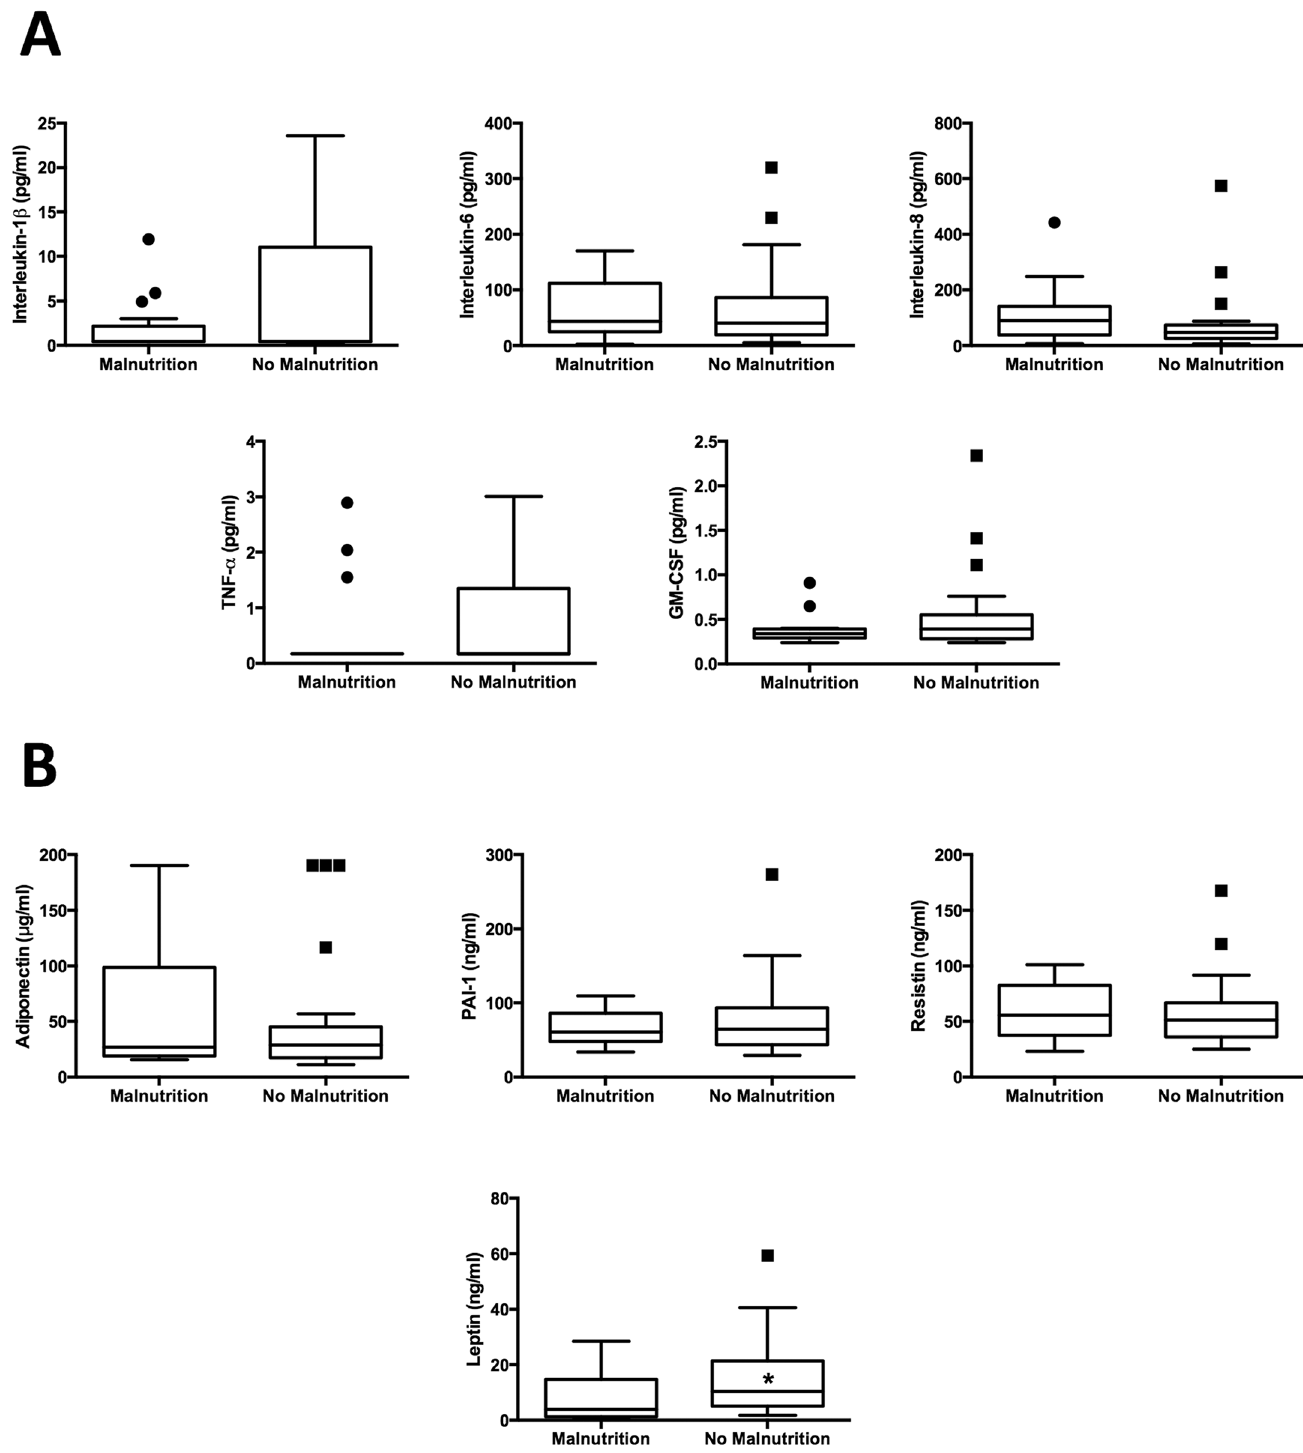
Fig 1. Tukey box whisker plots of circulating concentrations of (A) inflammatory cytokines [interleukin-1 β , interleukin-6, interleukin 8, tumor necrosis factor- α (TNF- α ) and granulocyte-macrophage colony stimulating factor (GM-CSF)] and (B) adipokines [adiponectin, plasminogen activator inhitior-1 (PAI-1), resistin, and leptin] in cirrhotic patients with and without malnutrition. * , p < 0.05.